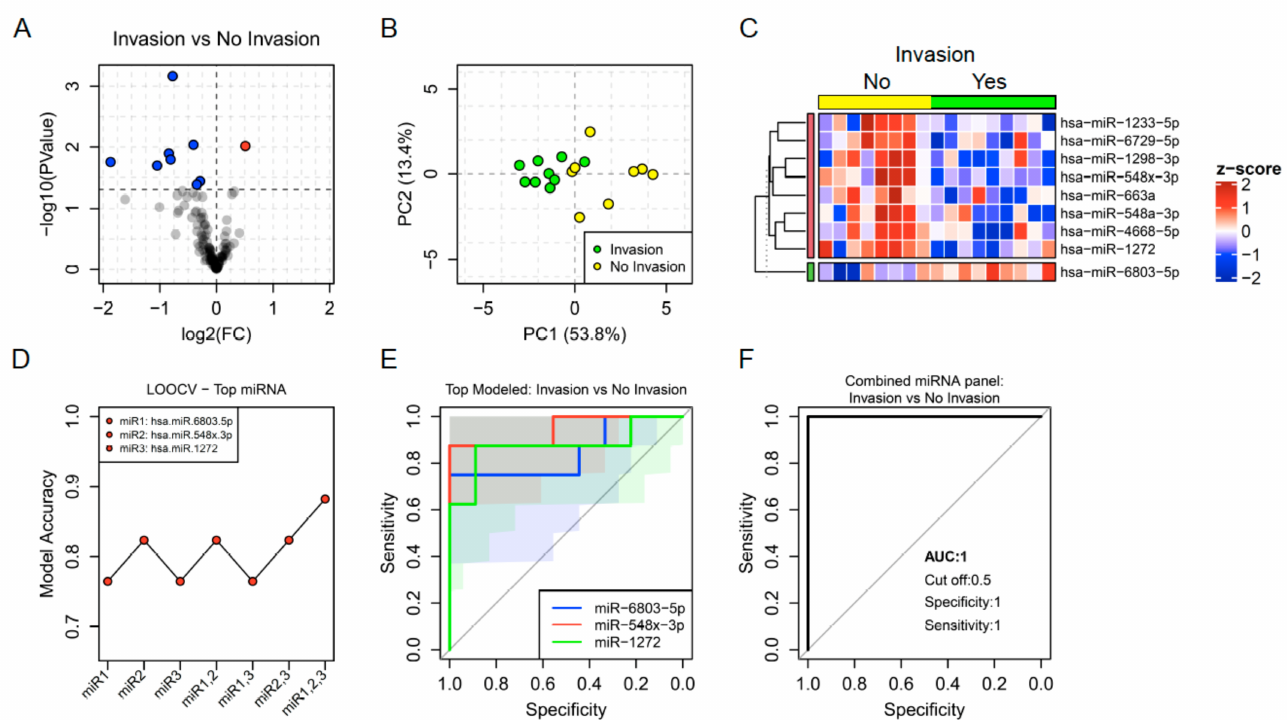
Figure 5. ( A ) Volcano plot showing fold change (FC) and statistical significance of individual miRNA levels in the breath condensate of lung cancer patients with invasion compared to those having no invasion. Blue and red dots represent negatively and positively regulated miRNAs respectively ( p < 0.05). ( B ) Regulated miRNAs calculated PCA plots showing the PC1 and PC2 scores for individual lung cancer patients with invasion (green dots) and patients having no invasion (yellow dots). ( C ) Heatmap showing z-score of miRNAs regulated in EBC from lung cancer patients with and without invasion. ( D ) Accuracy of invasion capacity prediction calculated by LOOCV models for individual miRNAs and for the four possible combinations. ( E , F ) ROC curves predicted for an individual ( E ) and combined miRNAs ( F ) selected through a random forest iteration